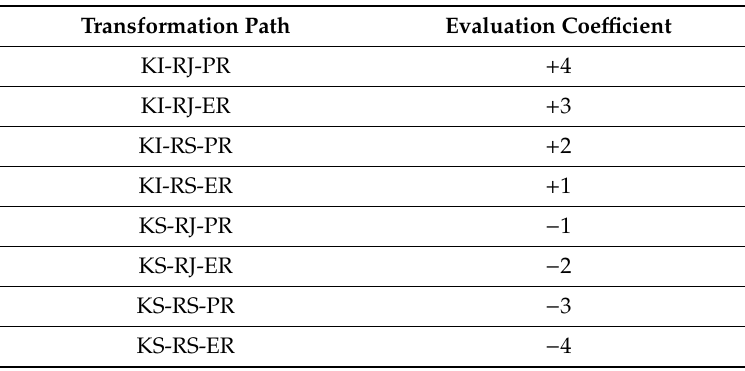
Table 3. The rapid risk transformation evaluation